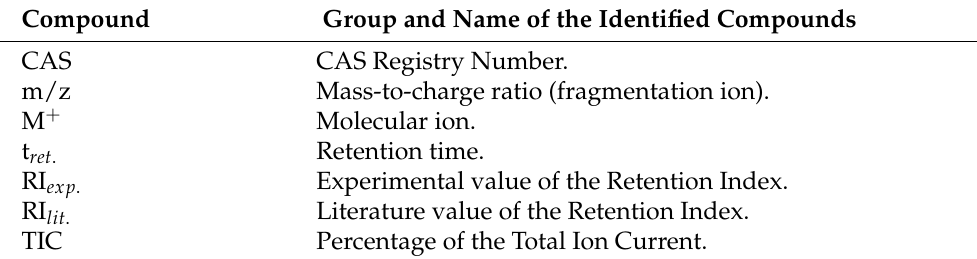
Table A2. Description of the columns in tables presenting the Gas Chromatography-Mass Spectrome- try